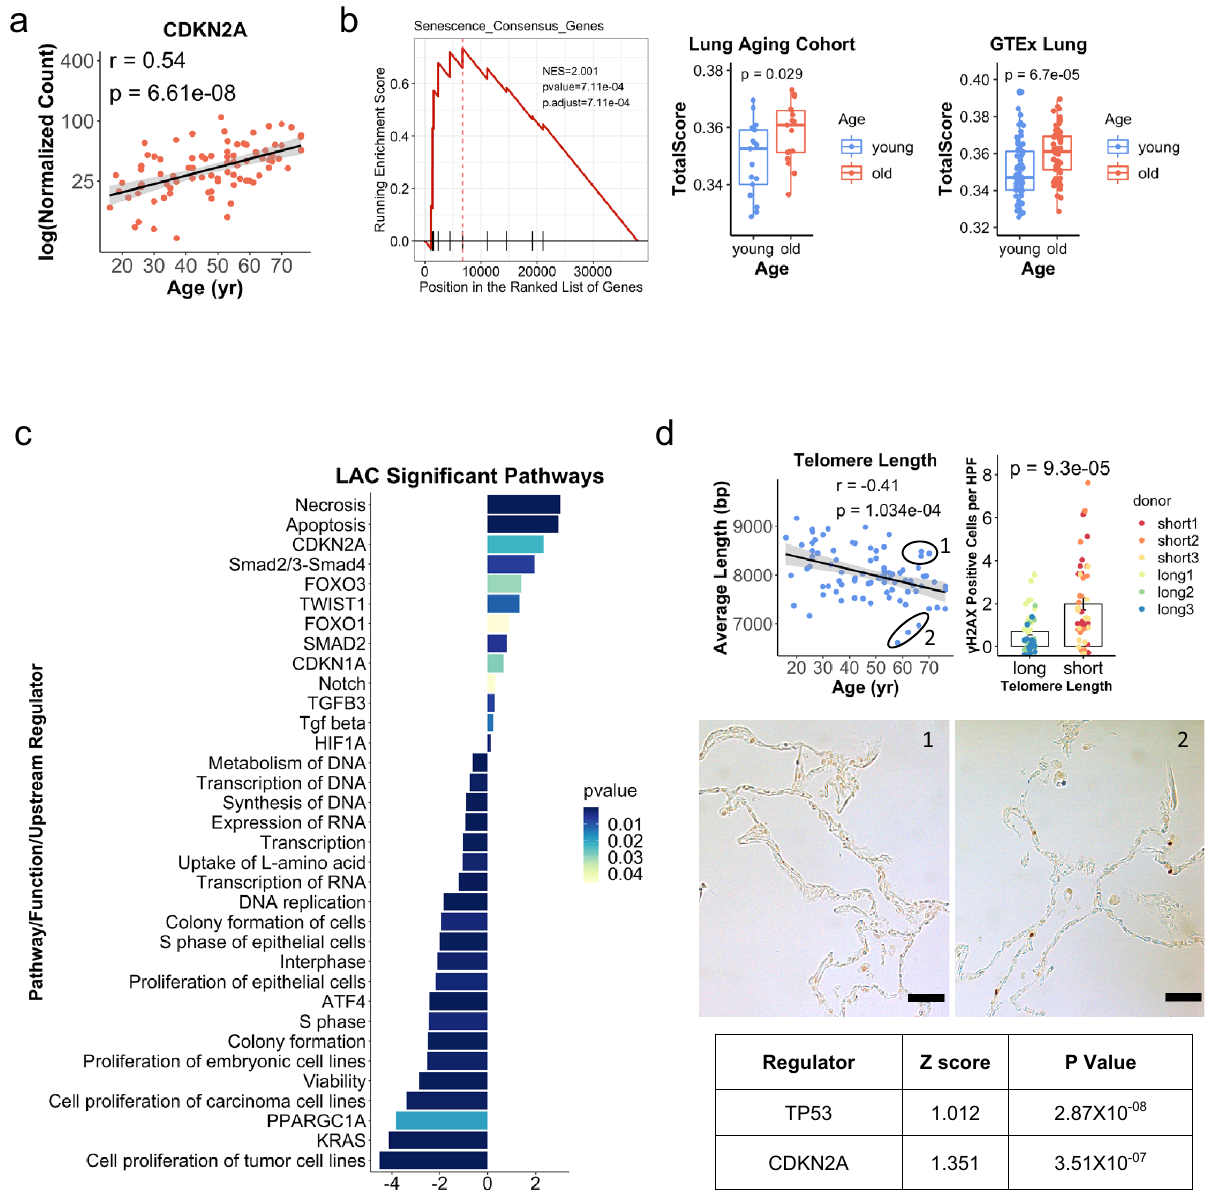
Fig. 2 Lung cellular senescence increases with aging. a p16 expression by age in the LAC (log scale). Pearson R is shown. The gray band represents the 95% con fi dence interval. b Gene set enrichment analysis of 11 consensus senescence markers from DePianto et al 15 . Genes were ranked by Pearson R between normalized gene expression and age. Normalized enrichment score, P value, and adjusted P value are shown. Single sample gene set enrichment analysis using the 11-gene signature is shown for individuals in the LAC ( N = 17 biologically independent samples in each group) and GTEx lung ( N = 69 biologically independent samples in each group). P values are for the two-sided Student ’ s t -test. For the boxplots, the middle line shows the median, the lower and upper hinges are the fi rst and third quartiles, and the lower and upper whiskers extend to the value at most 1.5 IQR below the fi rst quartile or 1.5 IQR above the third quartile, respectively. Data beyond the end of the whiskers are outlying points. c Ingenuity pathway analysis (IPA) computed with the genes from LAC that were correlated with age at p ≤ 0.05 level of signi fi cance. P values are for right-tailed Fisher ’ s exact test without adjustment for multiple comparisons. d qPCR-quanti fi ed telomere length plotted by age for the LAC ( N = 84 biologically independent samples). Pearson R is shown. The gray band represents the 95% con fi dence interval. The circled subsamples differ in telomere length (1 = long, 2 = short) and were used for γ H2AX immunohistochemistry, with representative images below (Scale bars: 25 µ m) and quanti fi cation to the right ( N = 3 samples in each group, N = 15 images examined per sample). Each point represents the number of γ H2AX + cells within a separate image. P value is for a two-sided Welch ’ s t -test comparing all values for the long telomere group versus the short. Data were presented as mean values ± SEM. Differential gene expression of the subsamples by bulk RNA-seq was used for IPA. The predicted activity of upstream senescence regulators in the short telomere subgroup, with Z -scores and P values, is shown in the